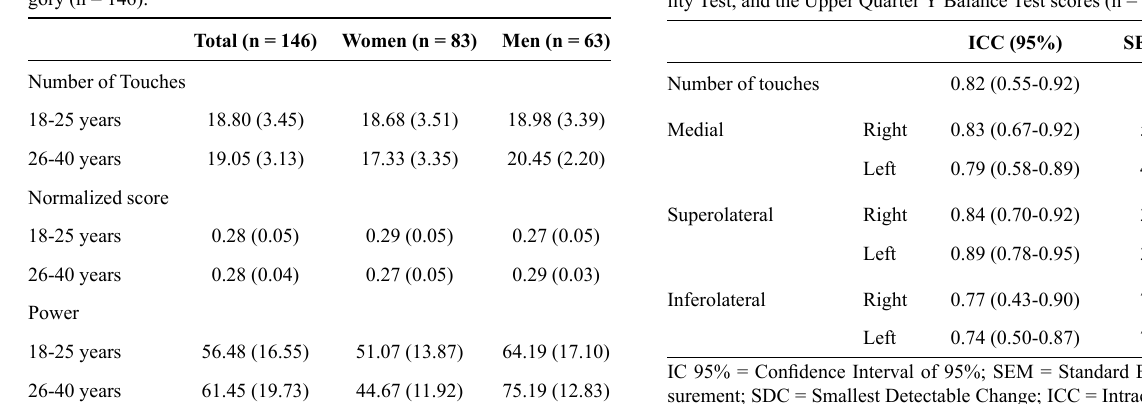
Table 4 - Intrarater reliability: Intraclass Correlation Coefficient with 95% Confidence Intervals, Standard Error of Measurement, and